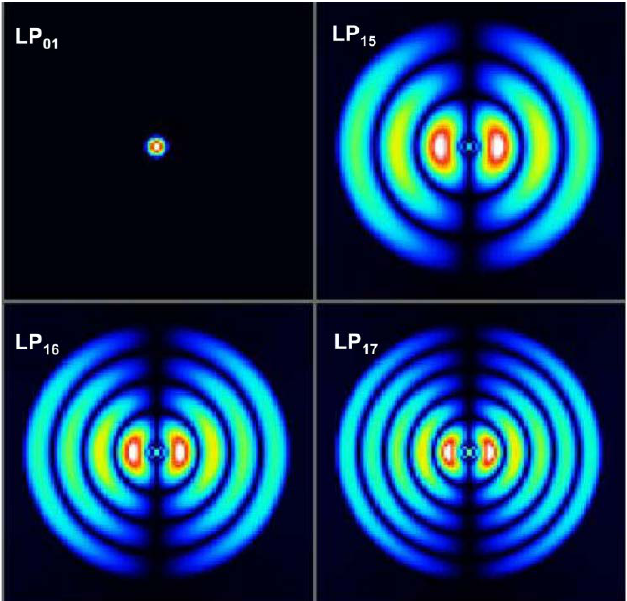
Figure 8. The mode profiles of different modes.